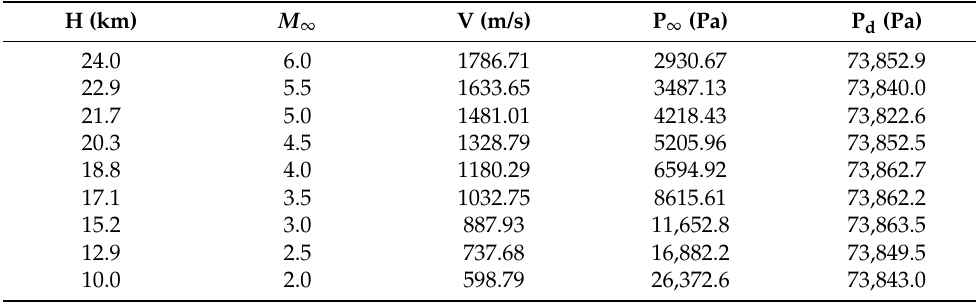
Table 2. Inflow conditions for numerical simulation.